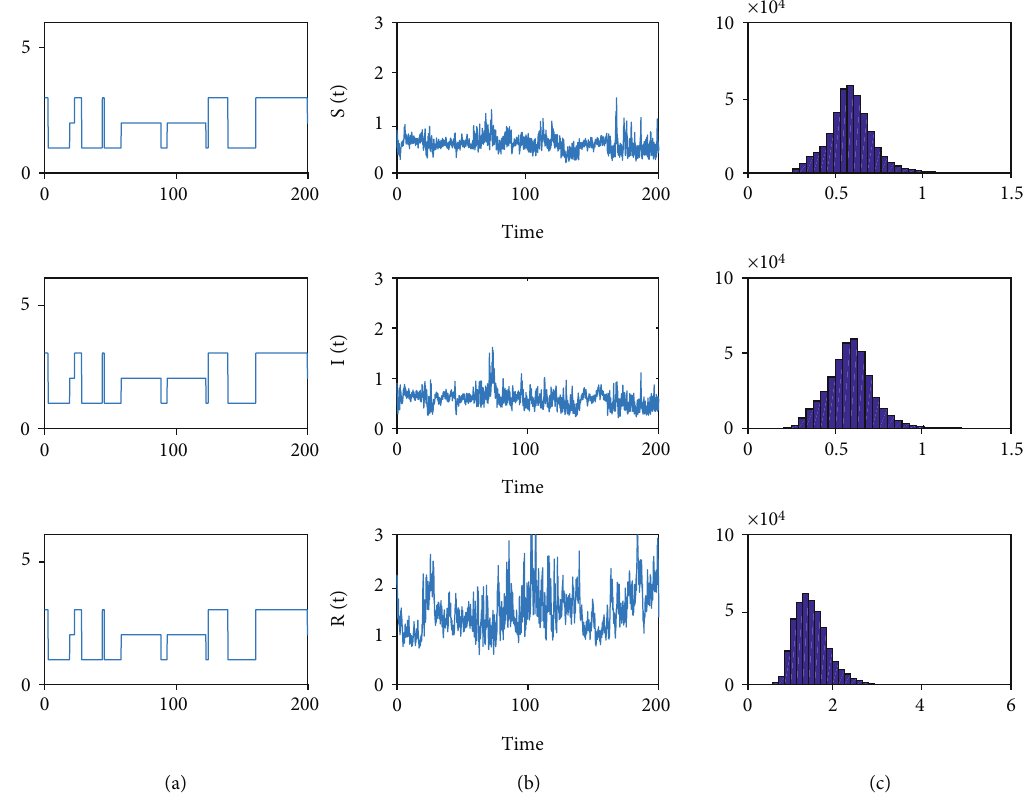
Figure 1: S ð t Þ , I ð t Þ , and R ð t Þ have ergodic property. The pictures in (a) are Markovian chain. The pictures in (c) are the density functions of model (2) for k ∈ M = f 1, 2, 3 g . The initial value S ð 0 Þ = 0 : 8, I ð 0 Þ = 0 : 7 , and R ð 0 Þ = 1 : 1 . Step size Δ t = 0 : 001